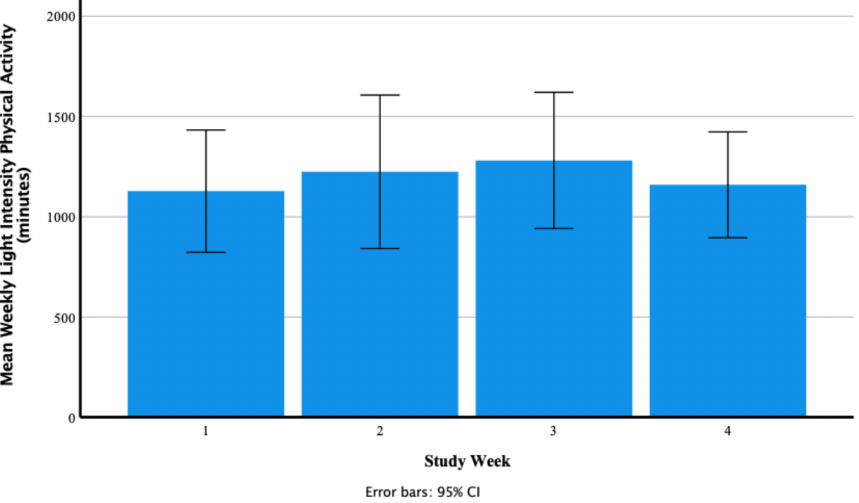
Figure 6. Participants’ mean weekly light intensity physical activity (minutes) as recorded via the Fitbit Charge 4 activity tracker.